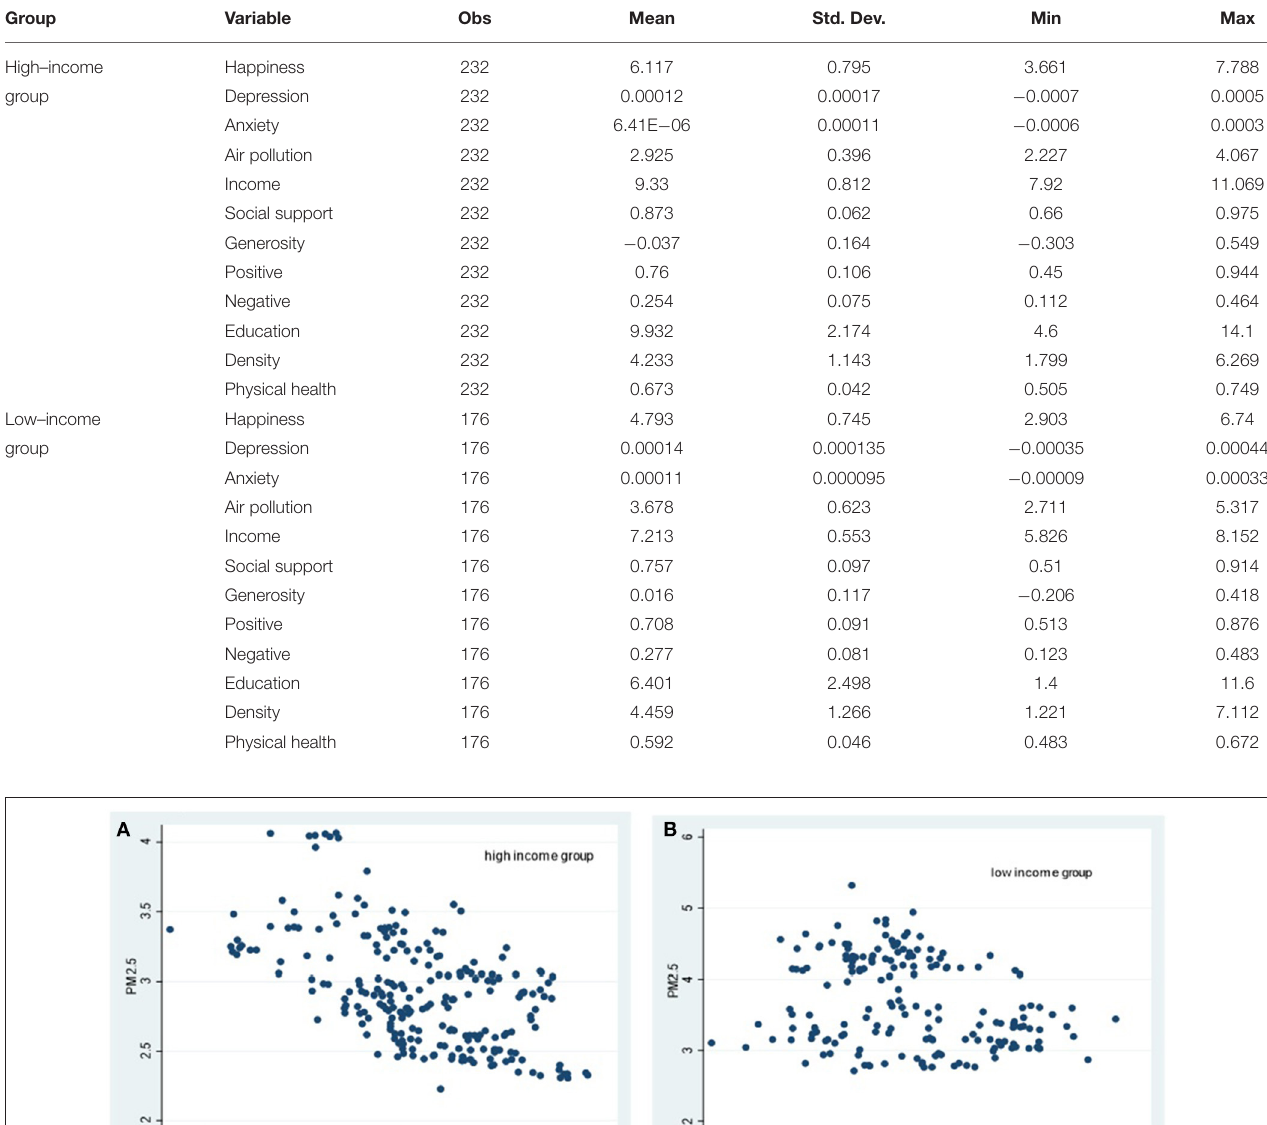
TABLE 8 | Descriptive statistics data of different income levels grouping.